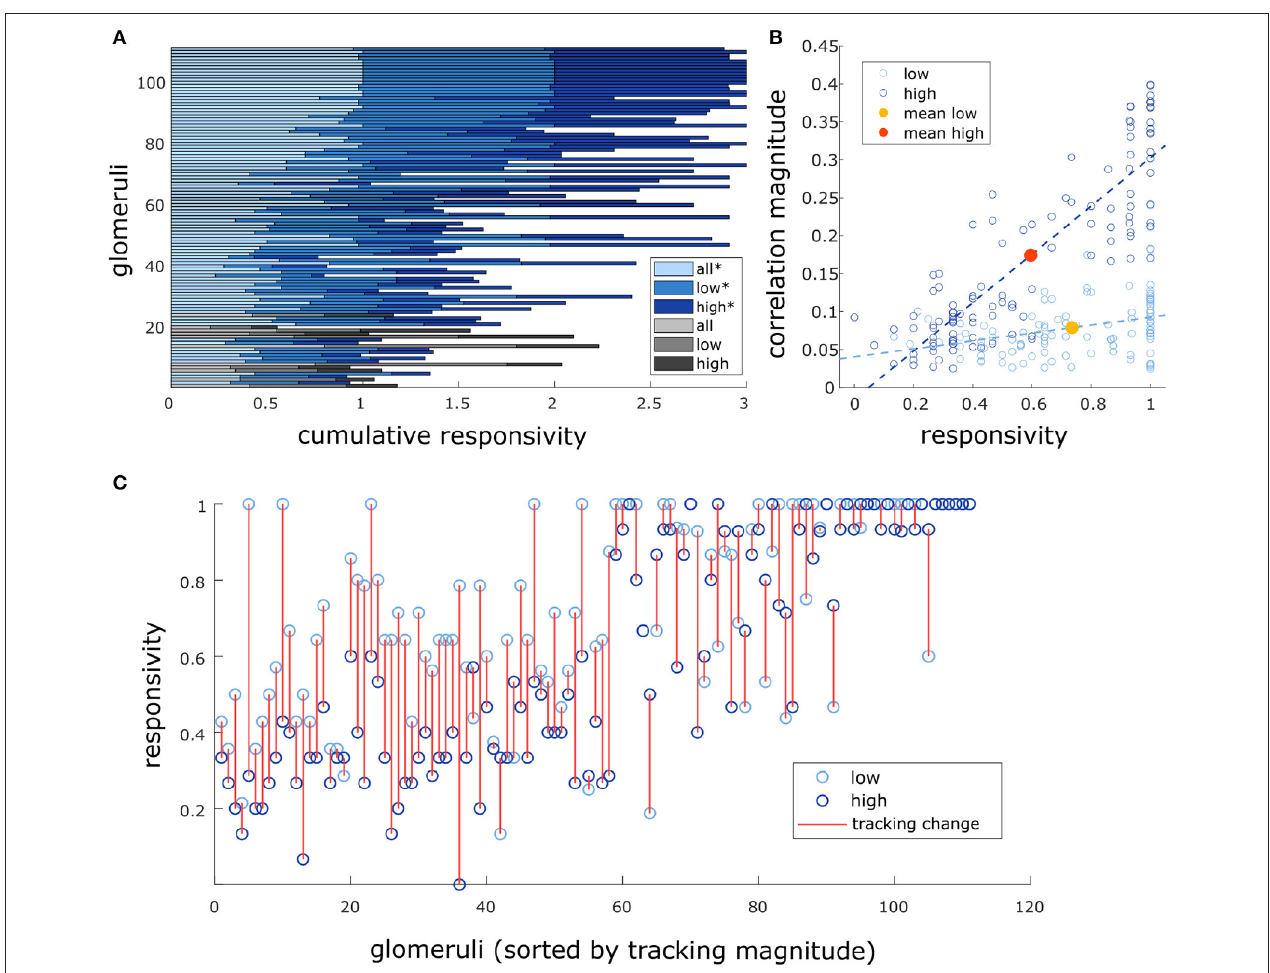
FIGURE 6 | Glomeruli that respond more reliably to plumes are more correlated with their dynamics. (A) Responsivity scores plotted as a cumulative bar graph to illustrate differences within and across glomeruli when responsivity is calculated across all conditions (lightest blue) or is calculated exclusively within low flow (medium blue) or high flow (dark blue). Glomeruli are sorted top to bottom by decreasing average tracking ability (correlation magnitude) and glomeruli that significantly track plume dynamics (as defined in methods) are plotted in blue hues(*) while those that do not are plotted in gray hues. The graph shows magnitude of odor concentration tracking is correlated with ( r = 0.76, p < 0.001), but is not strictly defined by response reliability as glomeruli exist that respond strongly to odor presence but not to concentration dynamics. In addition, within flow comparisons show responsivity is significantly higher in low flow than high flow [ t (110) = 12.1263, p < 0.001]. (B) Within flow condition, responsivity is plotted against tracking ability (correlation magnitude) for each glomerulus (circle). To represent the population response, the average responsivity across all glomeruli (low average = yellow dot, high average = red dot) is plotted against average correlation with plume dynamics within low (light blue) and high (dark blue) flow conditions illustrating how flow moderates these relationships. Across glomeruli, responsivity is positively correlated with tracking ability as is illustrated by the lines of best fit. On average, higher flow predicts a decrease in average responsivity level but also predicts an increase in tracking ability. (C) Average responsivity in low and high flow is plotted for each glomerulus, and the change in mean responsivity between flows shown in (A) is explicitly plotted for each glomerulus (red line) as well. Glomeruli are sorted by increasing tracking ability (from left to right) showing glomeruli with higher response reliability are more sensitive to plume